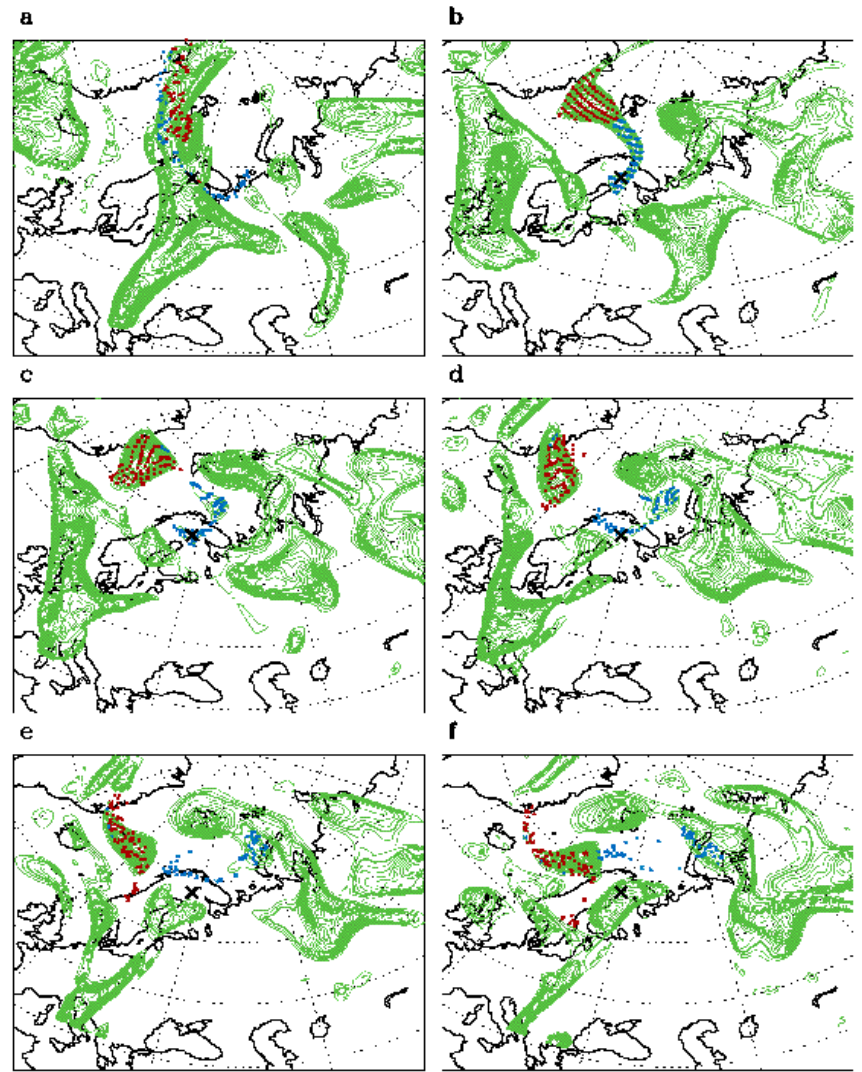
Fig. 6. Locations on the 295K surface of (a) end-points of backward trajectories at 00:00UTC on 15 February, (b) initial positions of trajectories at 12:00UTC on 16 February; (c)–(f) end-points of forward trajectories at (c) 00:00UTC (d) 12:00UTC on 17 February; (e) 00:00UTC (f) 12:00UTC on 18 February. In each case the locations are superimposed on the corresponding PV chart. Only PV > 1.6PVU is coloured. Sodankyl¨a is marked with a